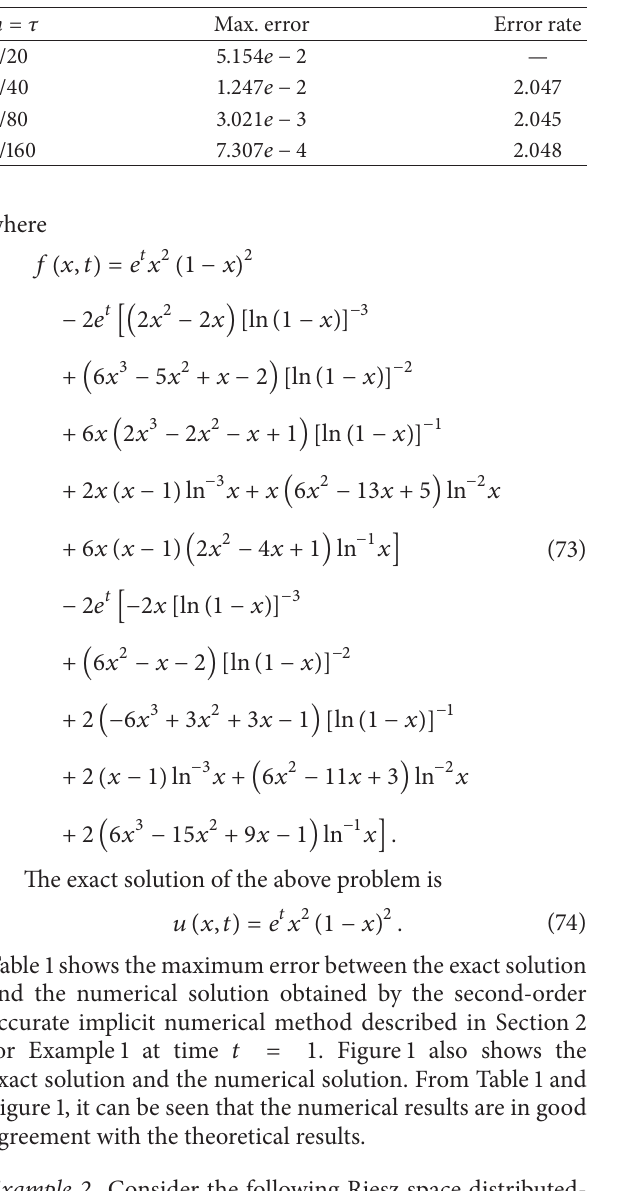
Table 1: The maximum errors for the numerical method and the convergence orders with 𝜎 = 𝜌 = 1/1000 and 𝜏 = ℎ at time 𝑇 = 1 .